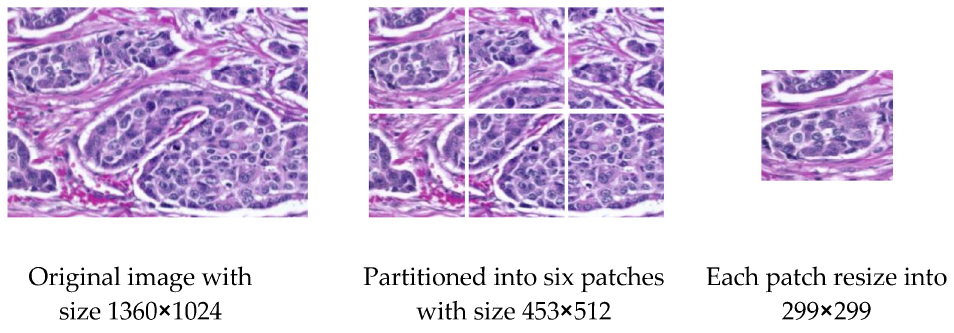
Figure 8. Example for Partitioning and resizing the IDC dataset.